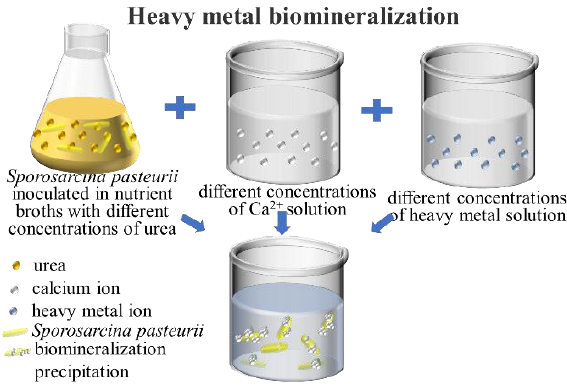
Figure 2. Test procedure of heavy metal biomineralization by acclimatized S.